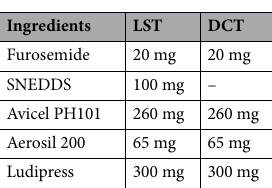
Table 1. The compositions of LST and DCT for 1 tablet.